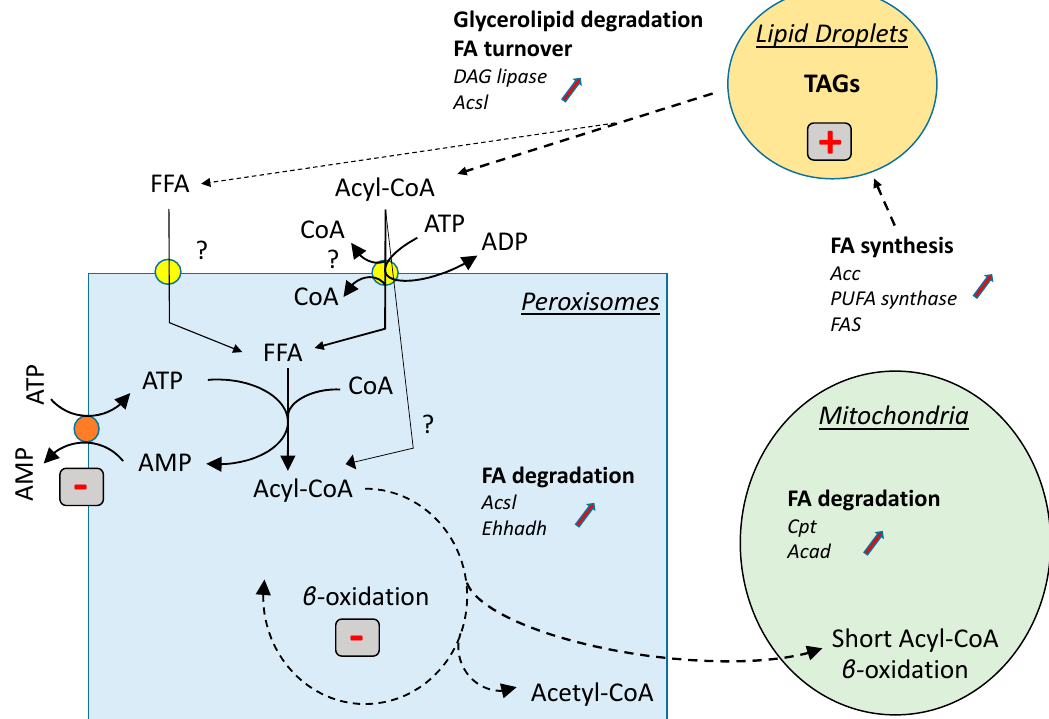
Figure 7. Scheme illustrating the cascade of events likely associated with a decrease of ATP import into peroxisomes. FAs produced from the degradation of TAGs enter peroxisomes through an ABC carrier or an uncharacterized free FA (FFA) transporter. Regarding the ABC carrier, it is not clear whether the CoA moiety is released in the cytosol or in the peroxisomal lumen, and if some acyl-CoAs can be transported as such. In peroxisomes, FFA are converted to acyl-CoAs, consuming ATP, before being oxidized through the β -oxidation cycle. The products of this oxidation cycle are shuttled to mitochondria for a complete oxidation to CO 2 and H 2 O. A deficiency in ATP import into peroxisomes slows down the β -oxidation activity, resulting in lower degradation of TAGs, which accumulate. As a consequence, genes involved in FA and glycerolipid degradation are upregulated, together with genes involved in FA biosynthesis (arrows). Acsl: acyl-CoA